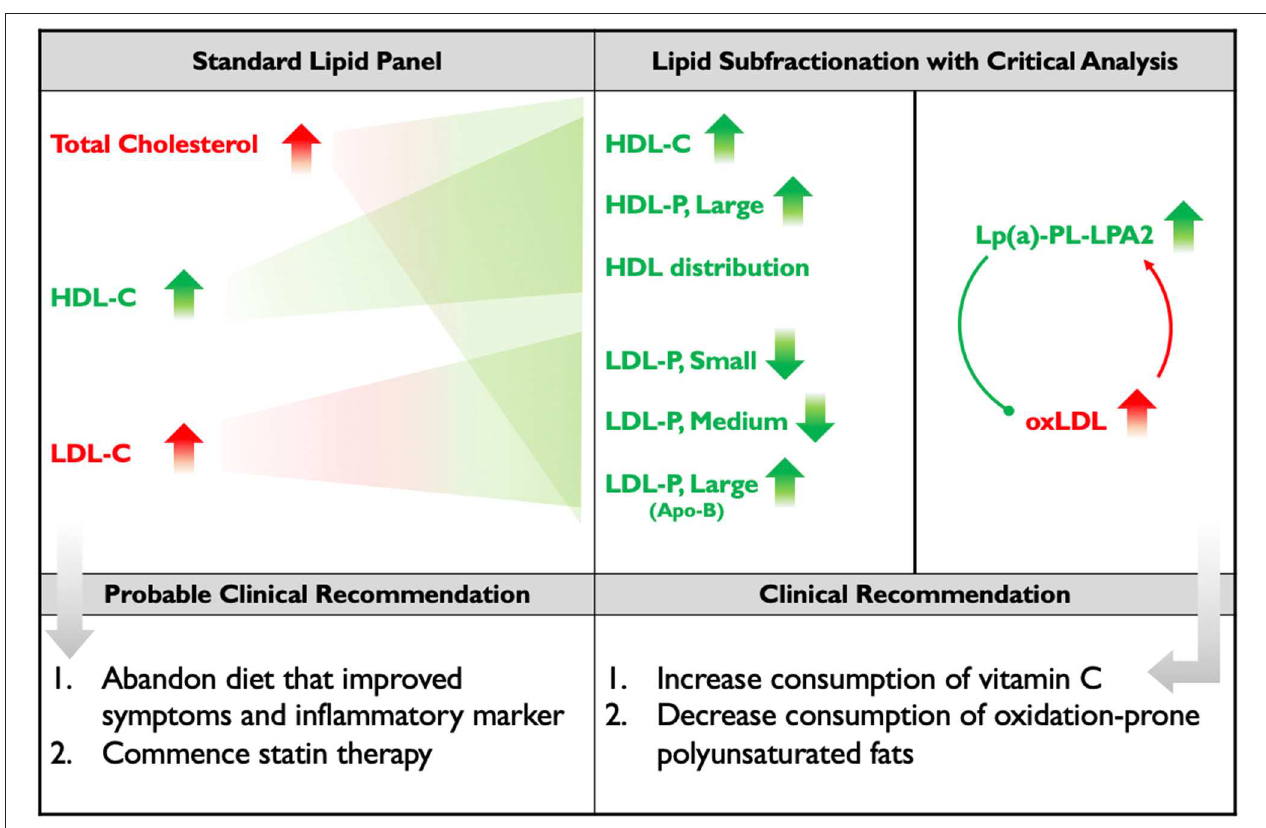
FIGURE 2 | Standard Lipid Panel vs. Lipid Subfractionation. The left column denotes changes induced by the subject’s diet that would have been detected on a standard lipid panel, along with the probable course of clinical action. The middle-right column denotes the changes that were detected by subfractionation and, below, the clinical course of action that was recommended. Red indicates changes presumed to be negative; green indicates changes presumed to be positive. Apo(B) is placed in parentheses, below large LDL, because the subject’s increase in Apo(B) mass was driven by his increase in large LDL. The diagram within the far-right column illustrates the hypothesis that the subject’s elevated Lp(a) and LP-PLA2 activity may represent adaptive, protective responses to the increase in his